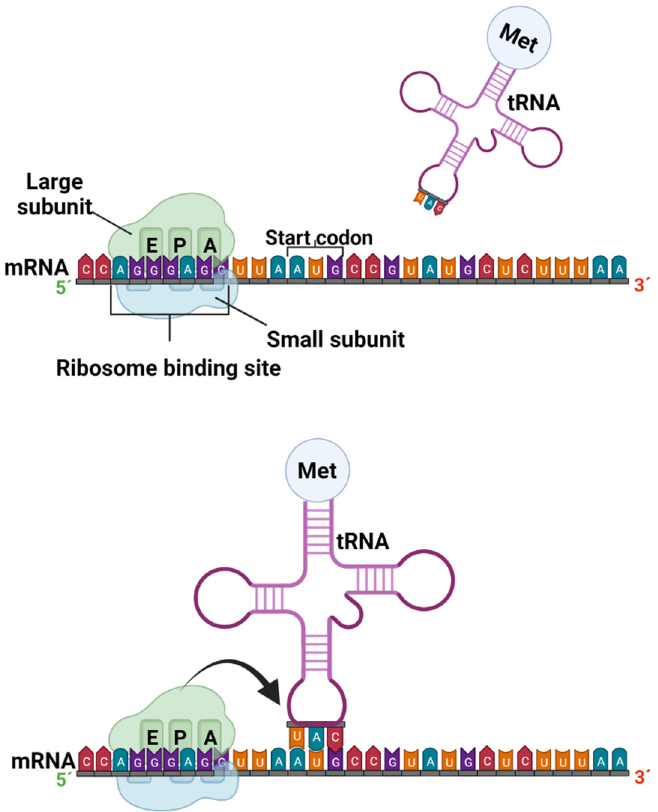
Figure 3. Formation of the preinitiation and initiation complex in the protein transcription process (created by Biorender.com) (accessed on 17 June 2022).